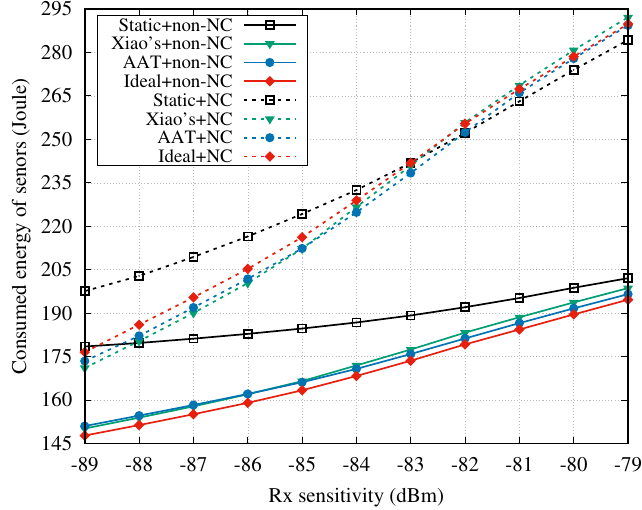
Figure 11. Energy consumption vs. Rx